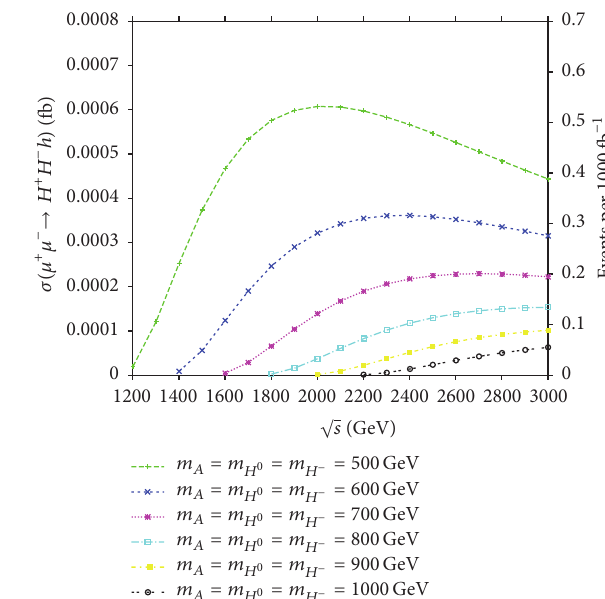
Figure 6: Triple Higgs production ( 𝐻 + 𝐻 − 𝐻 0 ) within 2HDM type II for various 𝑚 𝐻 ± values. Neutral Higgs bosons have masses equal to the mass of the charged Higgs.